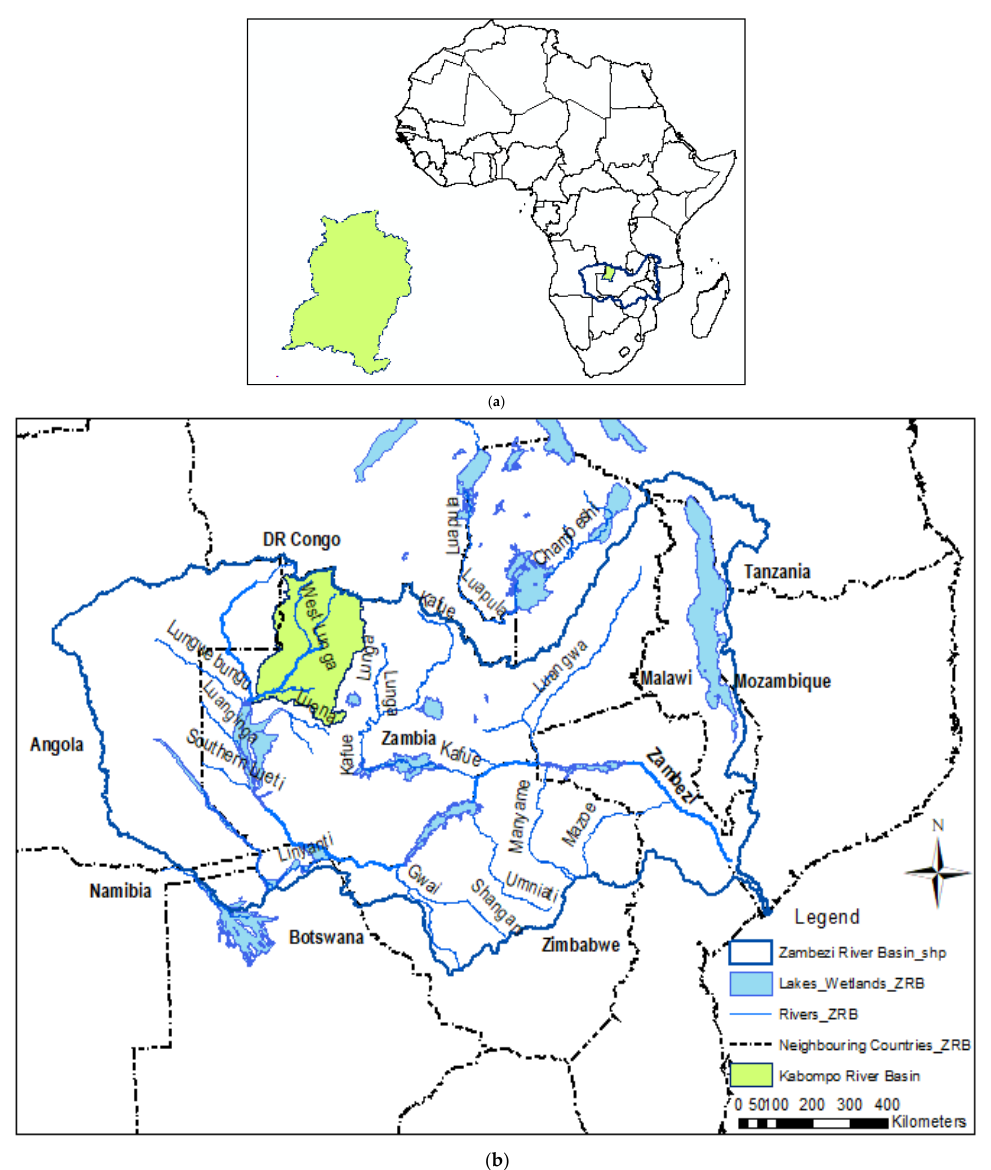
Figure 1. ( a ) Location of Study area in Africa. ( b ) The study area in the Zambezi River Basin [21] The KRB has a humid and subtropical climate. This basin records average yearly rainfall of 1200 mm, yearly average runoff of 100 mm, and high river flows of 240 m 3 /s [22], making a significant contribution to surface water and groundwater resources in the entire Upper ZRB. According to previous studies [22,23], the runoff coefficient is very low in the ZRB and is usually less than 10% of the Mean Annual Precipitation (MAP) on aver- age. The coldest month is July with mean monthly temperatures of less than 13 °C, while October is the hottest month with a mean daily temperature of 29 °C. The potential evap- otranspiration (PET) is estimated to be about 1300 mm [23]. The KRB has not been spared from global warming, as the decadal mean temperature rose in most of the ZRB ranges from 0.21 °C to 0.33 °C between 1960 and 2006 [24]. The basin has a high potential for rain- fed and irrigated agriculture productivity and important potential sites for hydroelectric power generation such as Chikata falls in the Kabompo district, the Kabompo gorge (un- der construction), Nyamwezi Falls, and Muzhila Falls in the Mwinilunga district. The ba- sin is also a home of an ecosystem with the West Lunga National Park, and economical centre of the country with large mines such as the Lumwana mine, (one of the largest mines in Africa), the Kalumbila mine and the Zabesha mine. The estimated population based on a 2010 census of the basin is 700,000 people with high poverty levels who rely on water resources for their livelihood. In view of the hydrological and social economic factors mentioned above, the KRB was identified to be strategic and hence chosen as a case study to demonstrate the impact of climate change on hydrology.